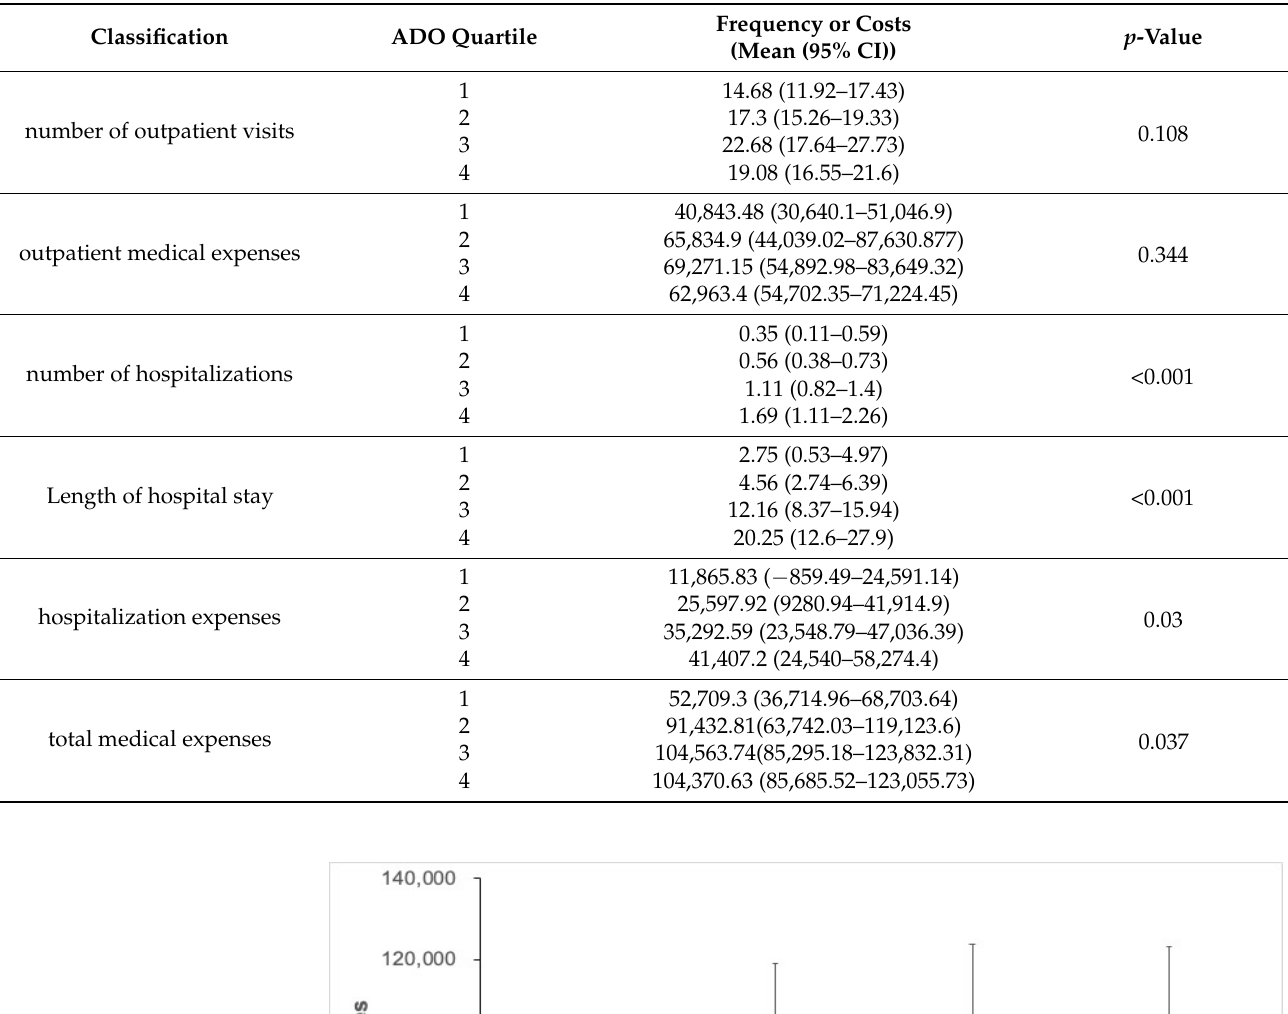
Table 3. Value of medical burden and ADO quartile.